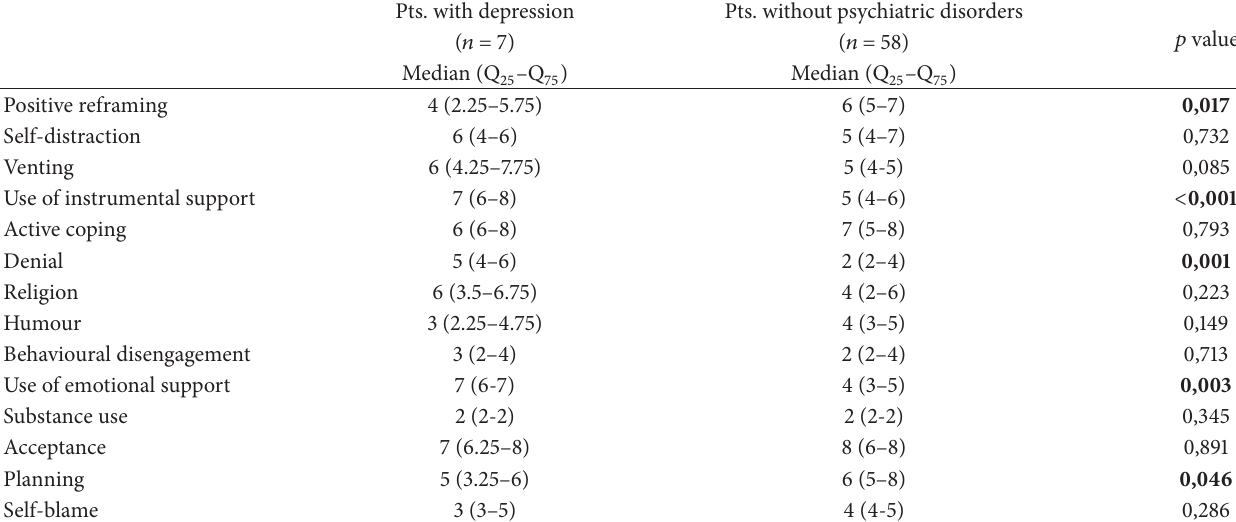
Table 2: Coping strategies in CD patients with depression and those without psychiatric disorders expressed as median of the scores of each item considered in the brief